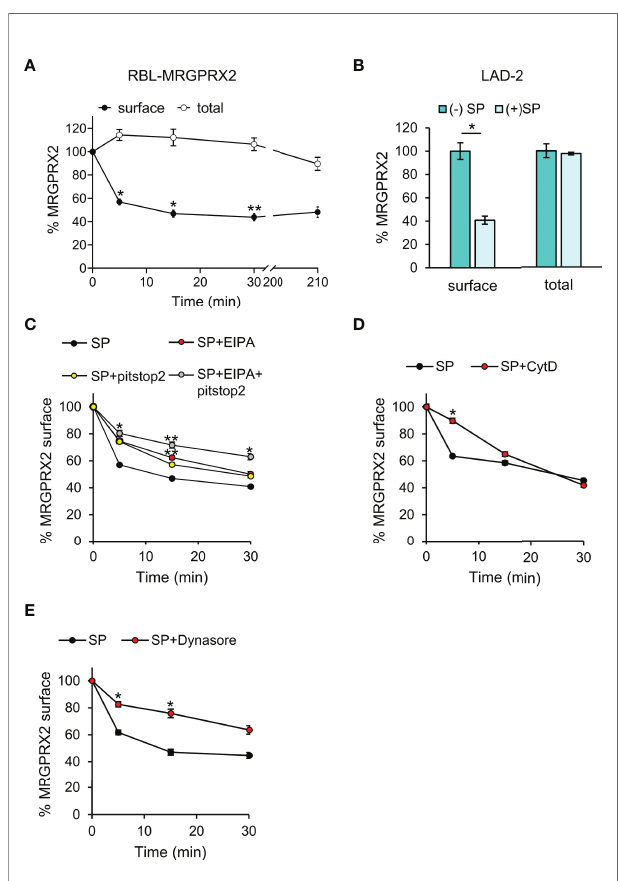
FIGURE 1 | MRGPRX2 internalizes into non-recycling and non-degradative compartment(s). RBL-MRGPRX2 cells (A, C – E) or LAD-2 cells (B) were incubated for 30 min with either vehicle (A, B) , or 20 µM pitstop2, 50 µM EIPA or their combination (C) , or 10 µM CytD (D) , or 80 µM dynasore (E) , as indicated. Cells were subsequently triggered with 10 µM SP for the indicated time periods (A, C-E) or for 30 min (B) and stained with anti-MRGPRX2 antibodies in the absence ( A , closed circles, B – E ) or presence of 0.1% saponin ( A , open circles, B ). Cells were analyzed by fl ow cytometry as described under Materials and Methods. Cell surface and total receptor expression are presented as the percentage of cell surface or total MRGPRX2 expression in the absence of trigger. Data are means ± SEM (n = 5-9). Statistical signi fi cance was determined by one – way ANOVA, followed by Dunnett ’ s post-test, for A - C. * P < 0.05, ** P < 0.01, and P < 0.05 for 5 min SP vs. 5 min SP +pitstop2, P < 0.01 for 5 min SP vs. 5 min SP + EIPA and P < 0.05 for 15 min SP vs. 15 min SP + pitstop2. Statistical signi fi cance was determined by unpaired two-tailed Student ’ s t-test for B, D and E * P [surface ( – ):SP vs. (+)SP] = 0.0156, * P [5 min: SP vs. SP+CytD] = 0.019, * P [5 min: SP vs. SP + dynasore] = 0.013, * P [15 min: SP vs. SP + dynasore] =